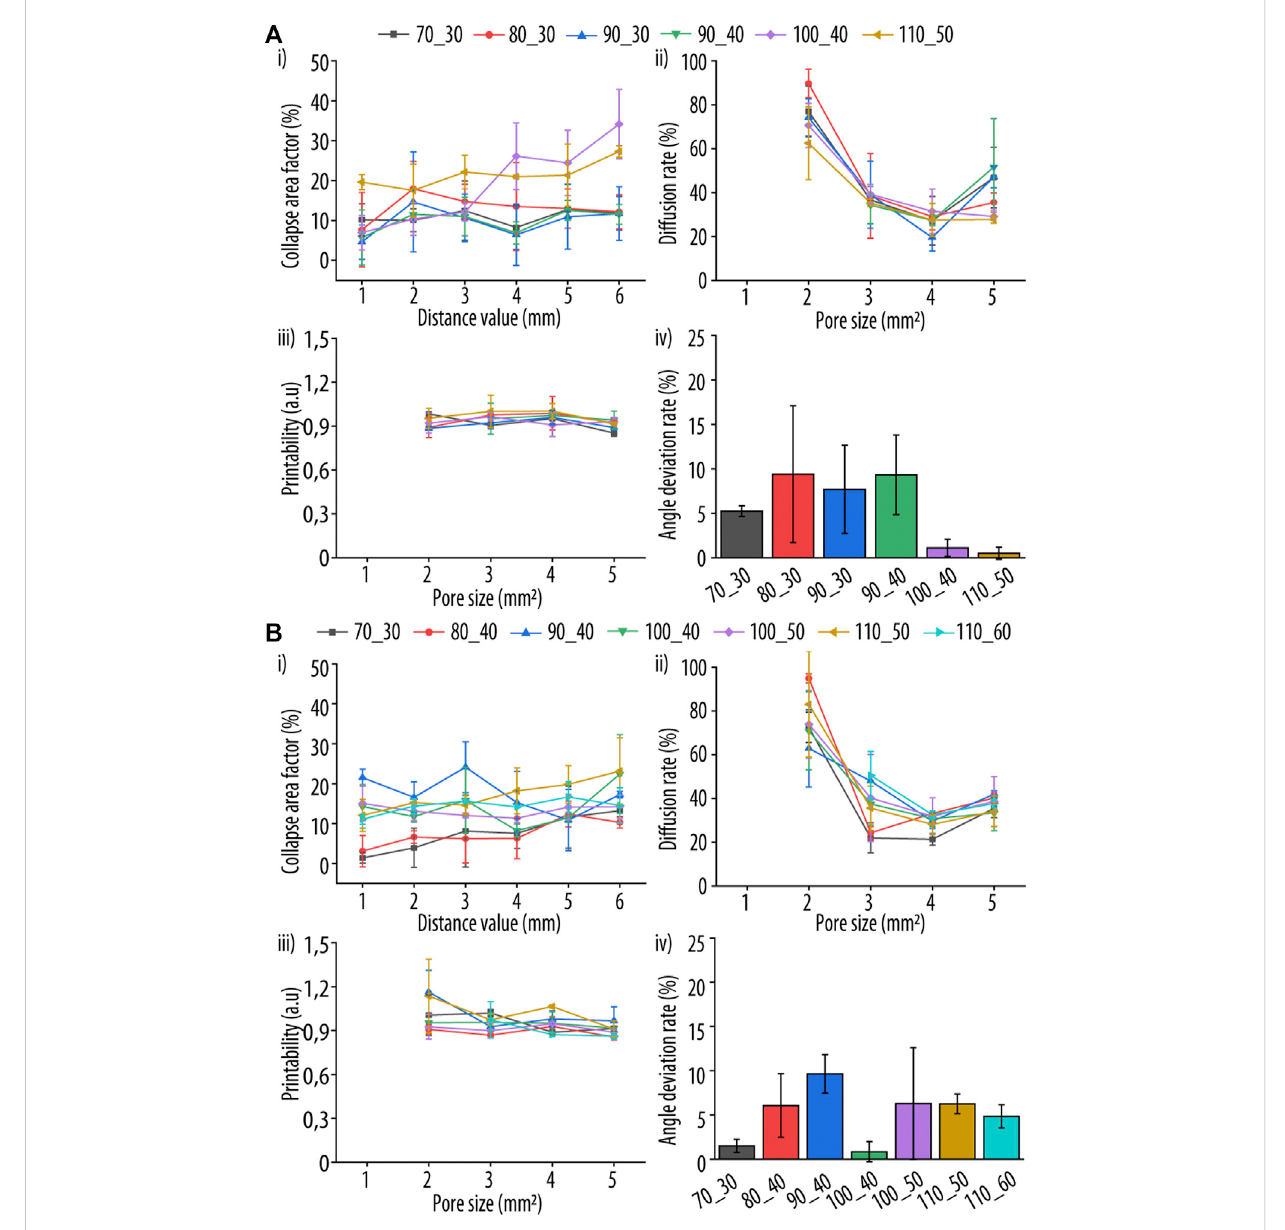
FIGURE 4 In-depth evaluation of two different ink parameters after printing to enable a comparative assessment of the tested guanosine (Guo)-acid boric derivatives (dBAs) (GB) formulation. Two dBAs were tested (A) boric acid (BA) and (B) 2-naphtylboronic acid (NPBA), and four different parameters evaluated:(i)collapseareafactor,correspondingtotheareaofthehanging fi lament,(ii)diffusionrate,representingthematerialspreadingontheprinting surface, (iii) grid printability, corresponding to the perimeter of the printed grid squares, and (iv) angle deviation rate, re fl ecting the shape and rectangularity of the printed square holes, respectively. Samples are coded as X_Y, where X and Y represent the millimolar concentration of Guo and dBAs/KOH,